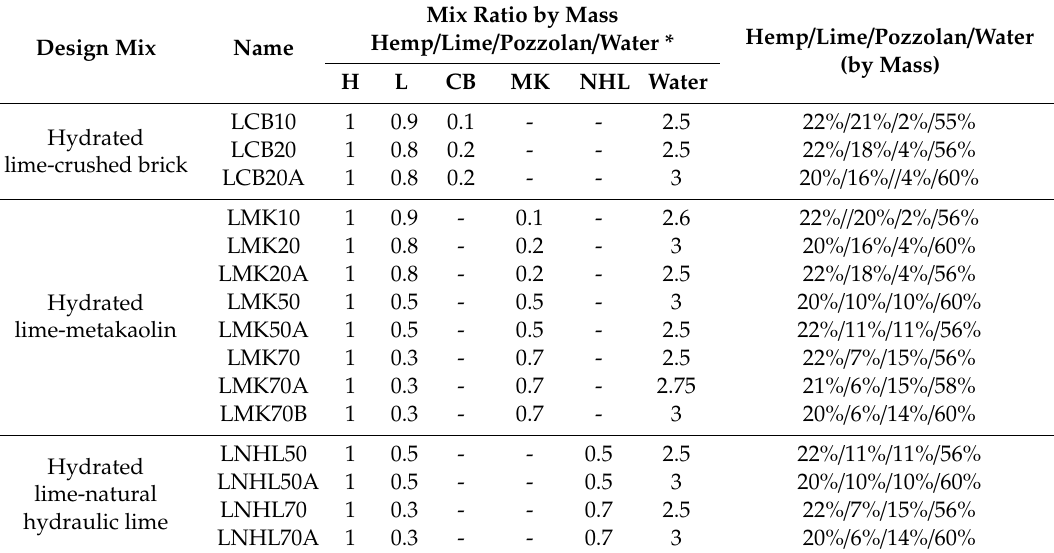
Table 1. Composition of hempcrete